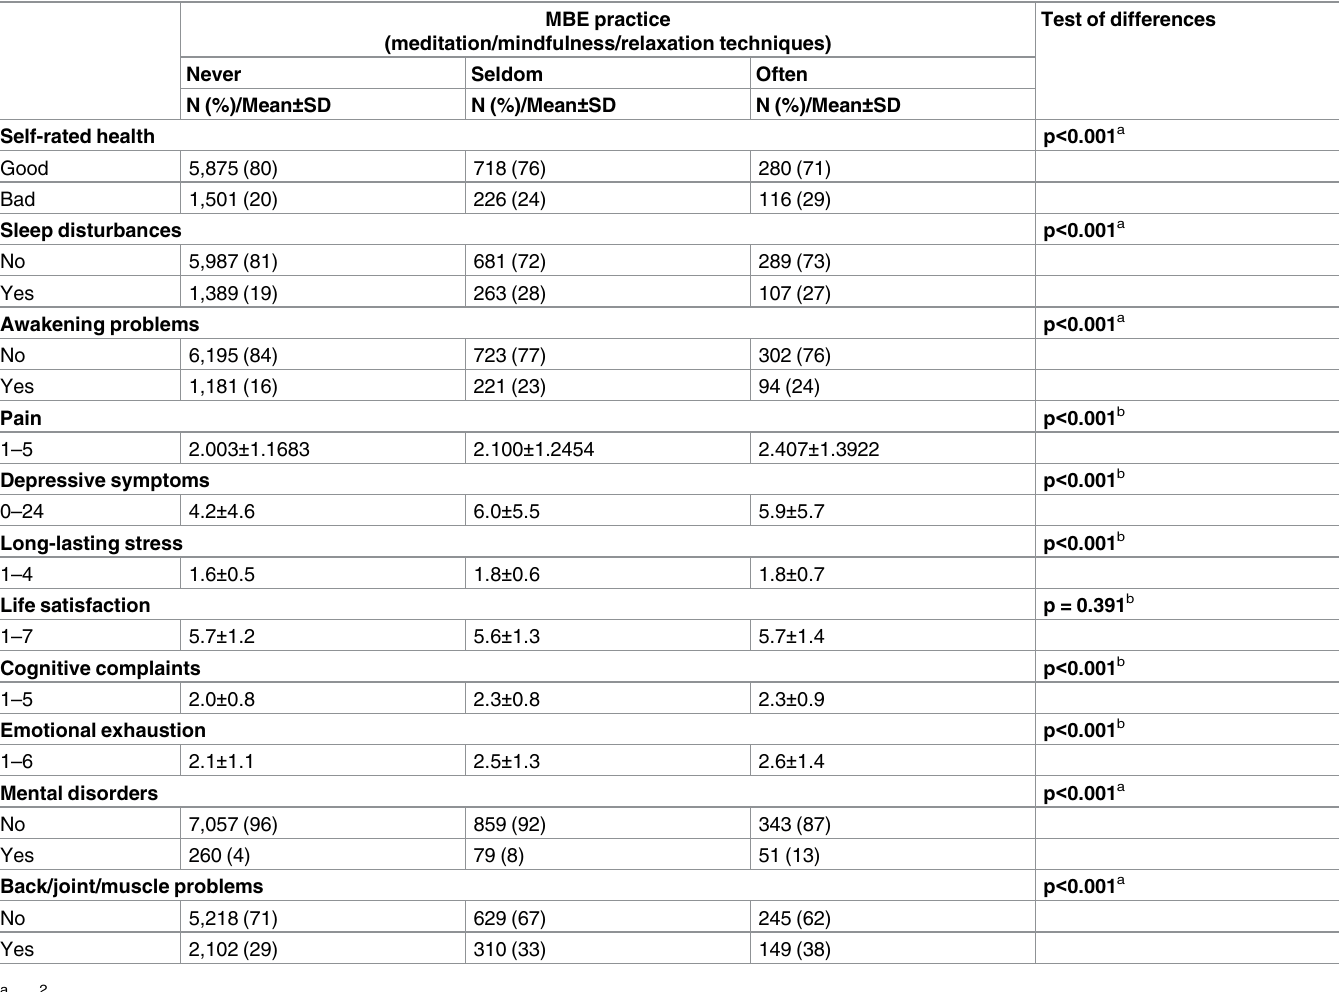
MBE practice (meditation/mindfulness/relaxation